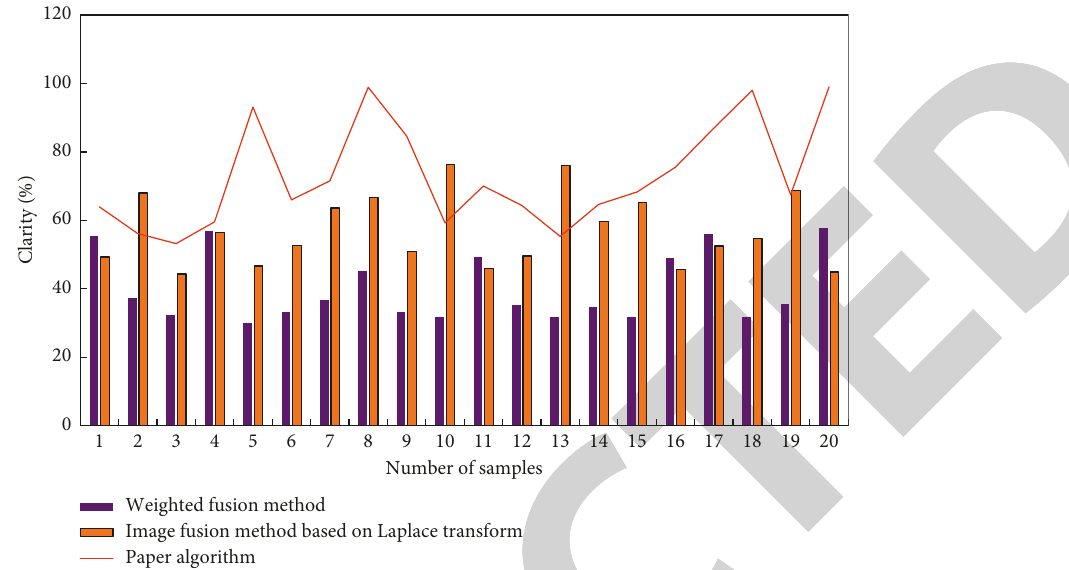
Figure 14: Comparison of weighted fusion method, image fusion method based on Laplace transform, and the